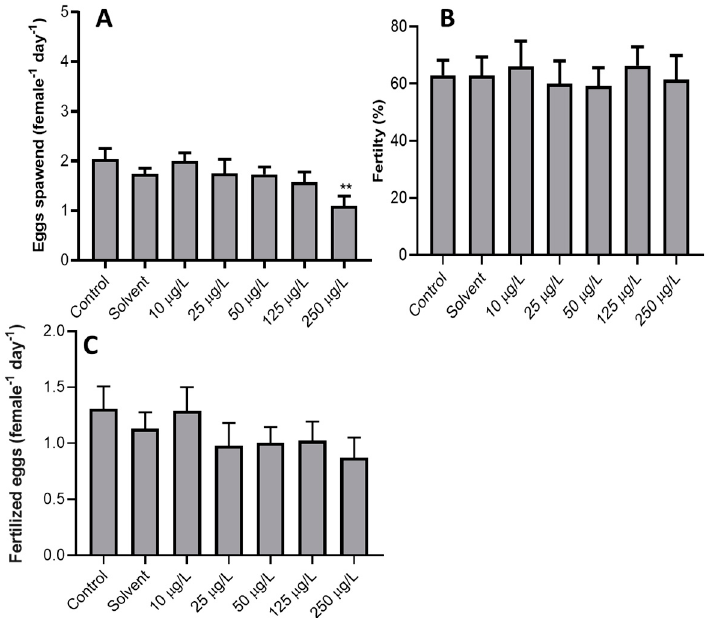
Figure 1. Fecundity of Javanese medaka (n = 3) exposed to sublethal concentration of 3,4-dichloroaniline (3,4-DCA) at 21 days exposure: ( A ) total eggs spawned, ( B ) fertility, and ( C ) fertilised eggs ** indicates a significant difference with control at p < 0.01. Error bar = ± standard error of mean (SEM).